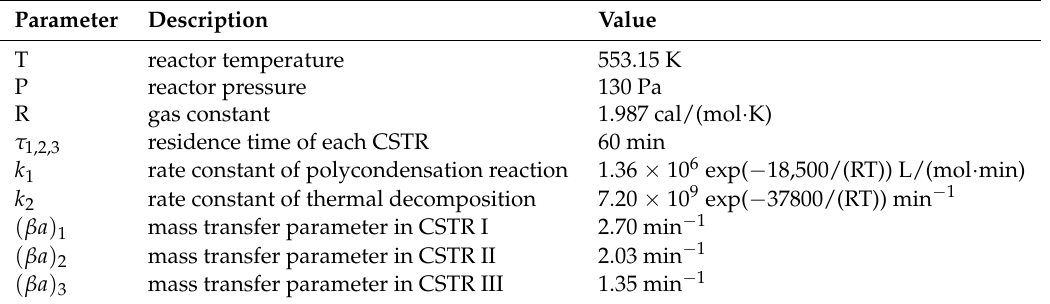
Table 1. System parameters a,b